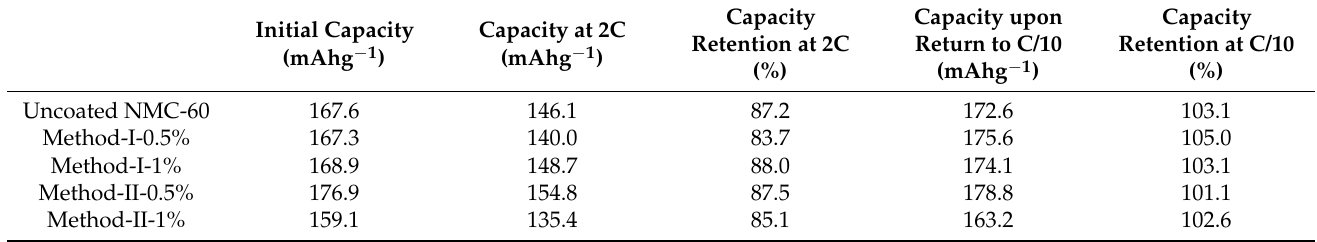
Figure 11. Rate performance of the uncoated NMC-60 and 0.5 wt.% and 1 wt.% LNO coating NMC-60 using Method-I and Method-II. Table 1. Comparison of rate performance at low and high C-rates.